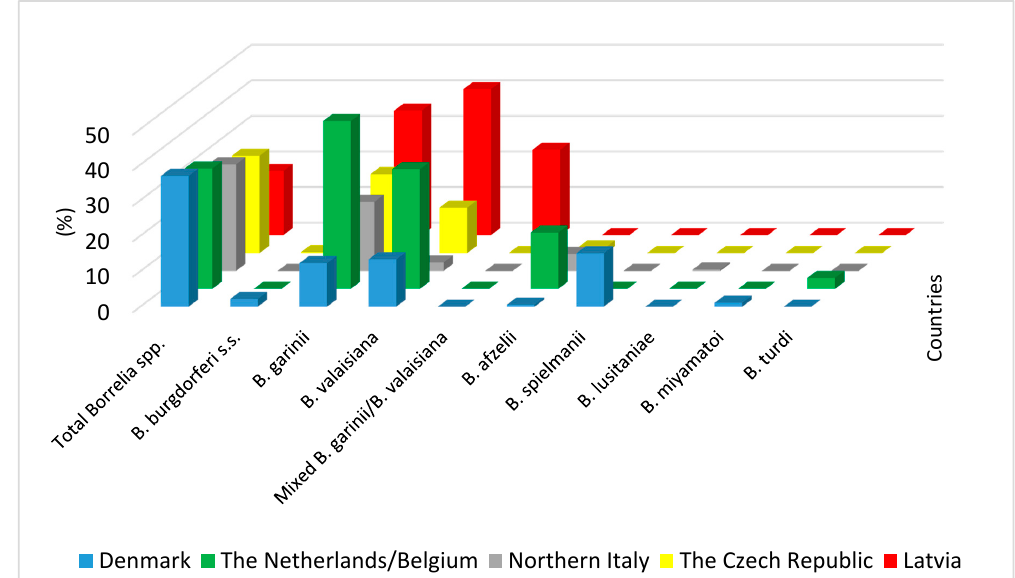
Figure 1. Prevalence of Borrelia spirochetes in birds infested by Ixodes ricinus ticks in selected areas of Europe [41,53,54,70,71].